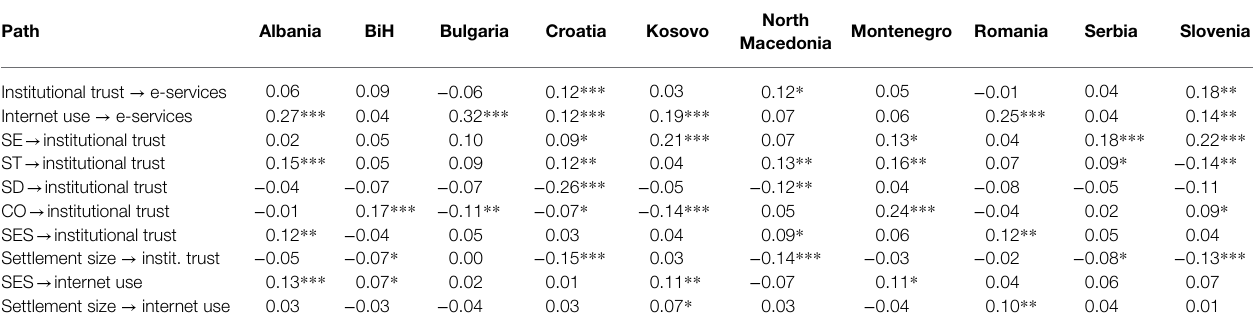
TABLE 3 | Standardised regression coefficients in the multigroup structural model of the relationship between value orientations, institutional trust and frequency of internet use towards engagement in e-services across countries.